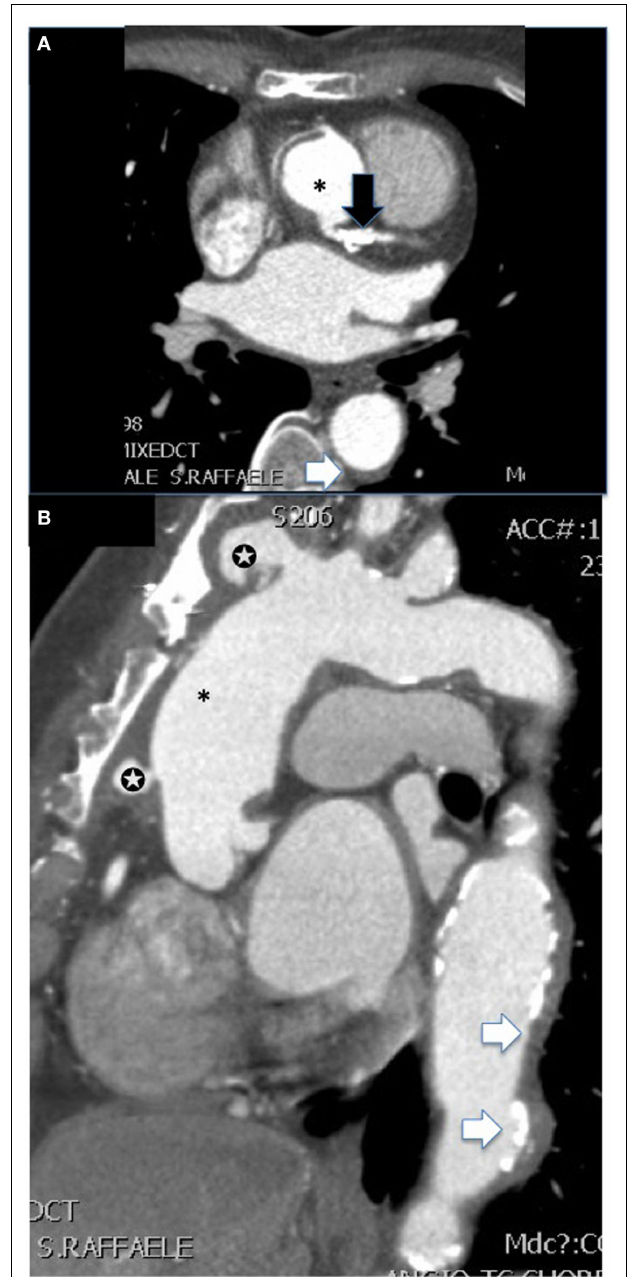
FIGURE 3 | CT angiography [(A) shows axial and (B) sagittal view] of the aorta of a female patient with advancedTakayasu arteritis who underwent previous surgical repair of an ascending aorta aneurysm (*) . Several features of the disease are summarized in these images: post-surgical complications such as pseudoaneurysms at the level of proximal and distal anastomosis of the vascular graft with the native aorta (white stars), extensive concentric mural thickening with calcifications of the aorta (white arrows), and presence of a stent in the main steam with a calcific stenosis (black